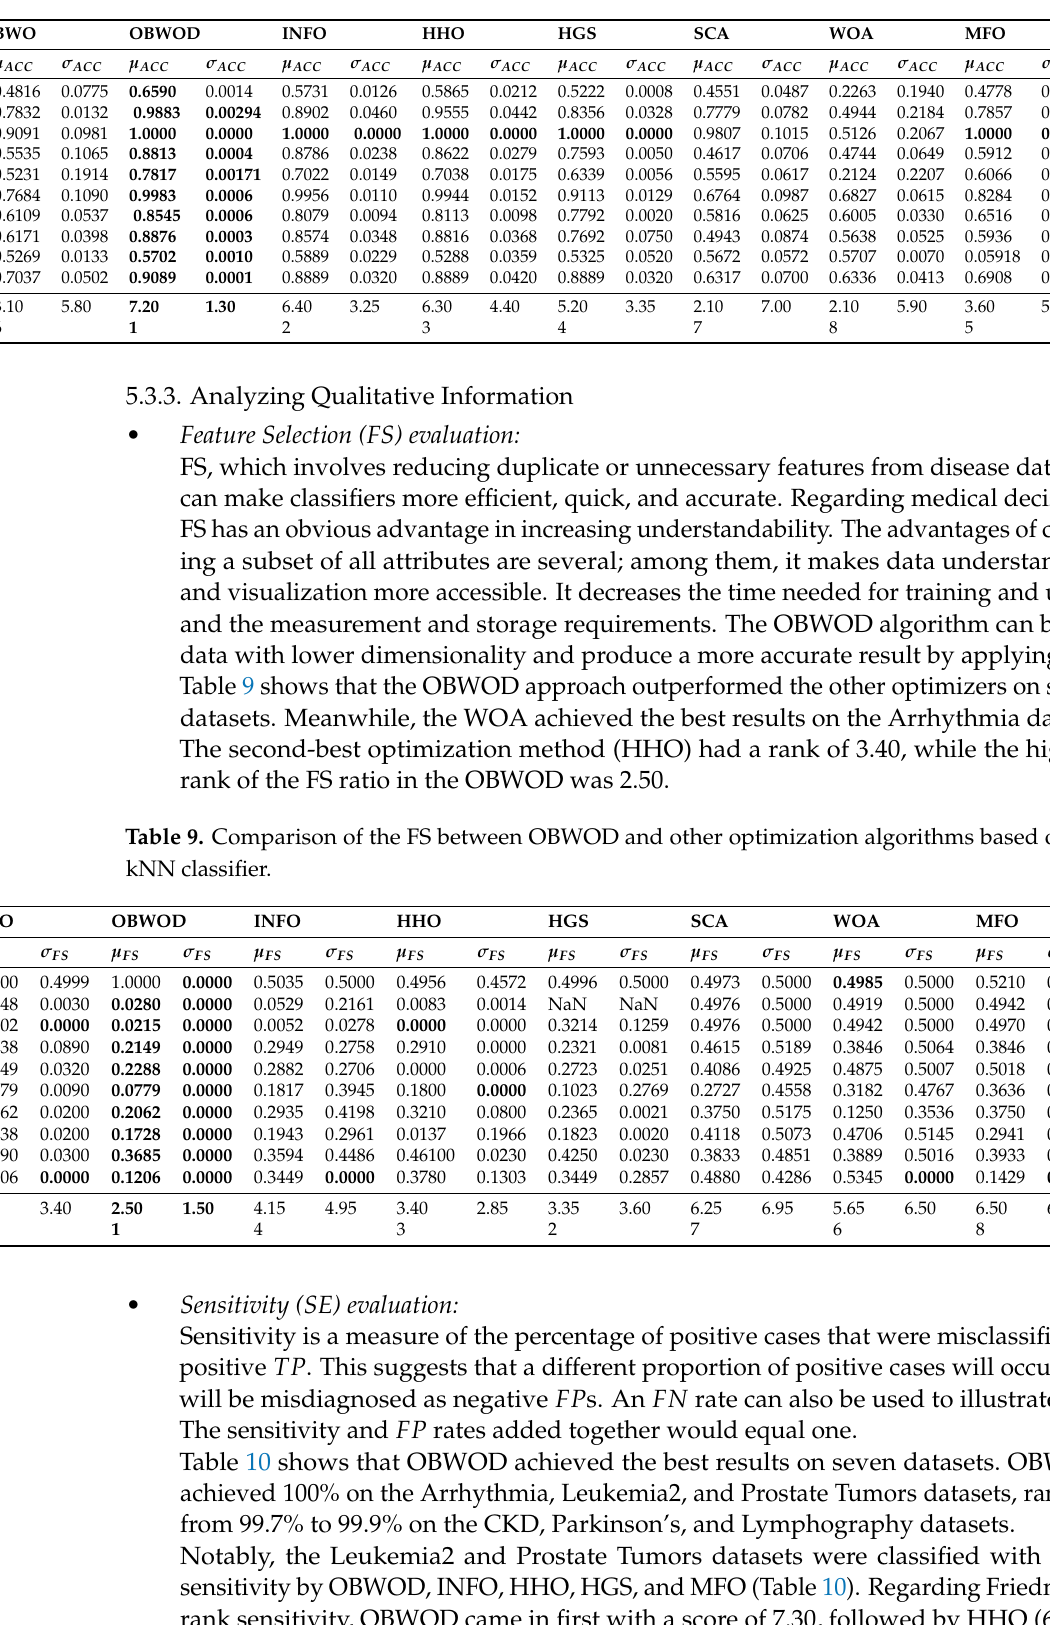
Table 8. Comparison of the accuracy between OBWOD and other optimization algorithms based on the kNN classifier.